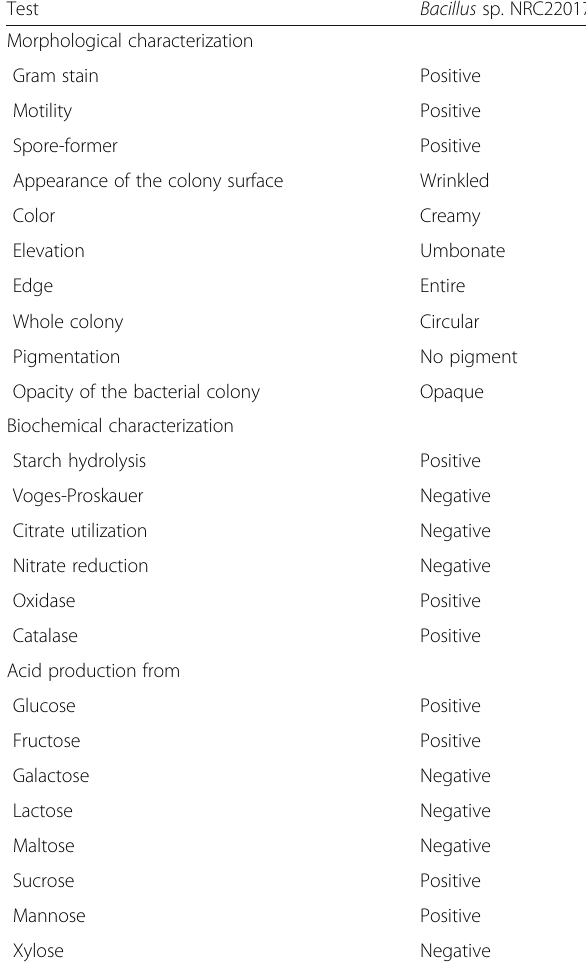
Table 1 Cultural and biochemical characteristic of the